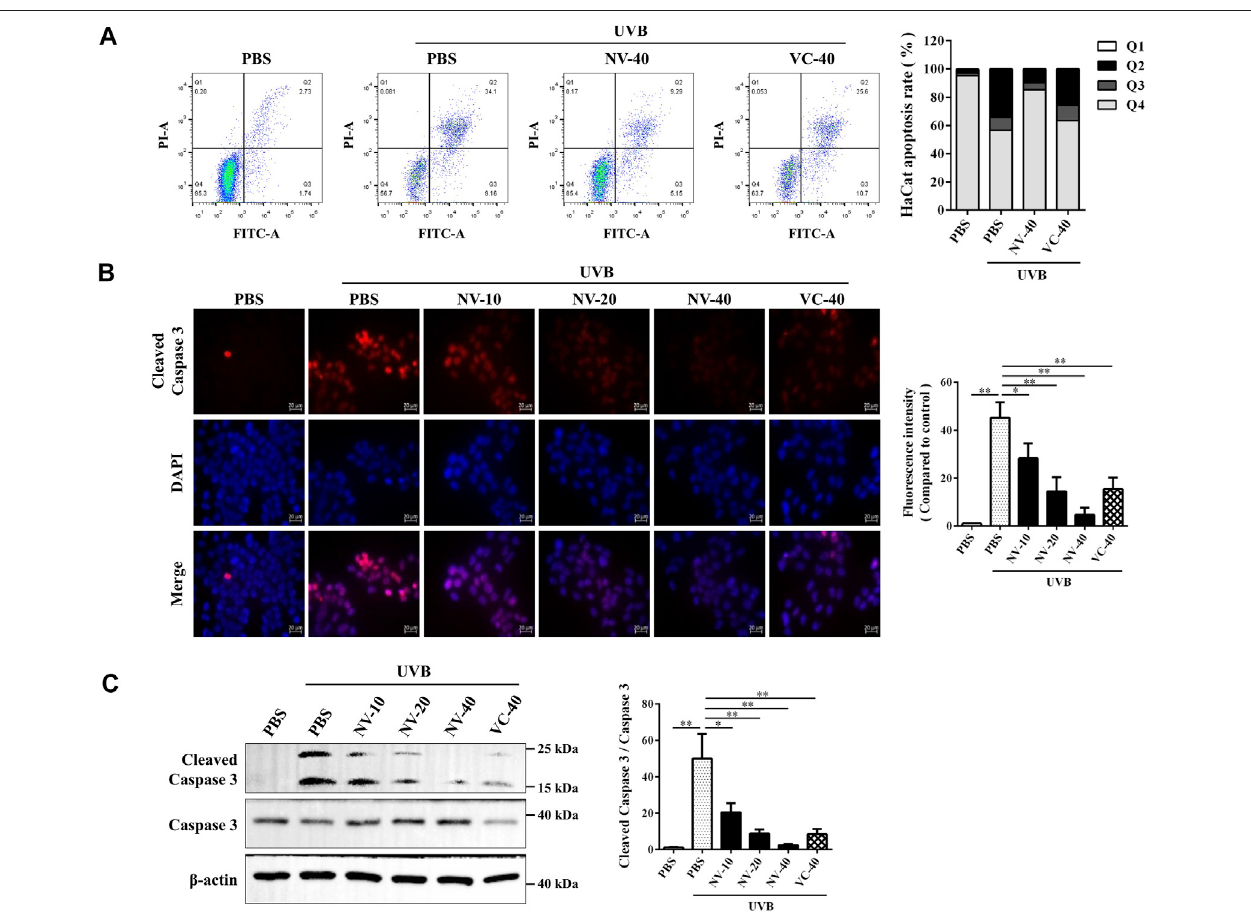
FIGURE 5 | Antioxidin-NV inhibited UVB-induced apoptosis and the expression of apoptotic protein Cleaved Caspase 3 in HaCaT cells. (A) HaCaT cells were treated with samples for 24 h after UVB irradiation and HaCaT cell apoptosis was analyzed by fl ow cytometry. (B) The expression of Cleaved Caspase 3 in HaCaT cells was analyzed by cell immuno fl uorescence analysis. Cleaved Caspase 3 proteins are stained red. Scale bar (cid:1) 20 μ m. (C) Western blot was performed to analyze the expression ofCaspase3andCleaved Caspase3proteinsinHaCaTcells.relativeactivationanalysiswerequanti fi edbyImageJ.Dataarepresented asmean ± SD ( n (cid:1) 3). NV-10, 20, 40, VC-40 indicated the concentrations of 10, 20, 40 μ g/ml respectively. * p < 0.05, ** p < 0.01.